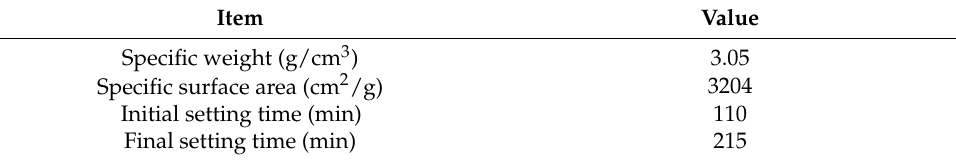
Table 2. Physical properties of OPC.